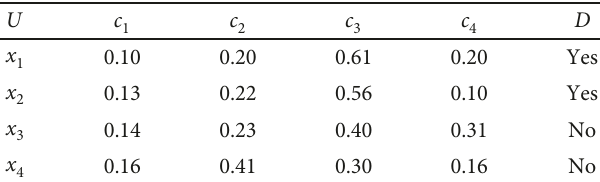
Table 1: Decision